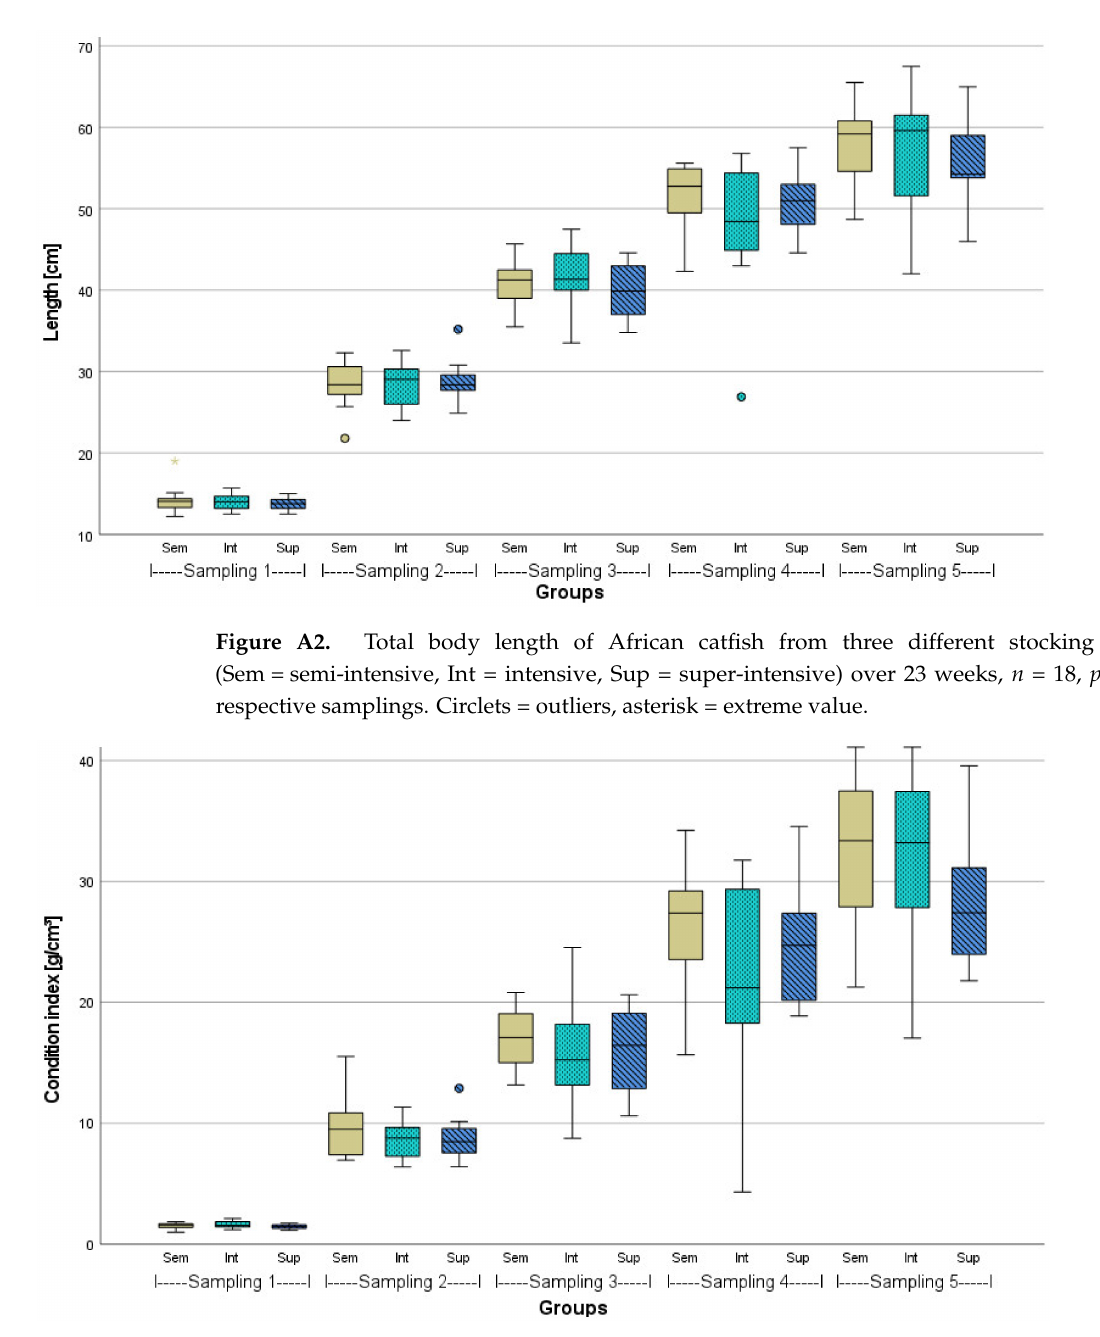
Figure A3. Condition indices of African catfish from three different stocking densities (Sem = semi-intensive, Int = intensive, Sup = super-intensive) over 23 weeks, n = 18, p > 0.05 in respective samplings. Circlet =